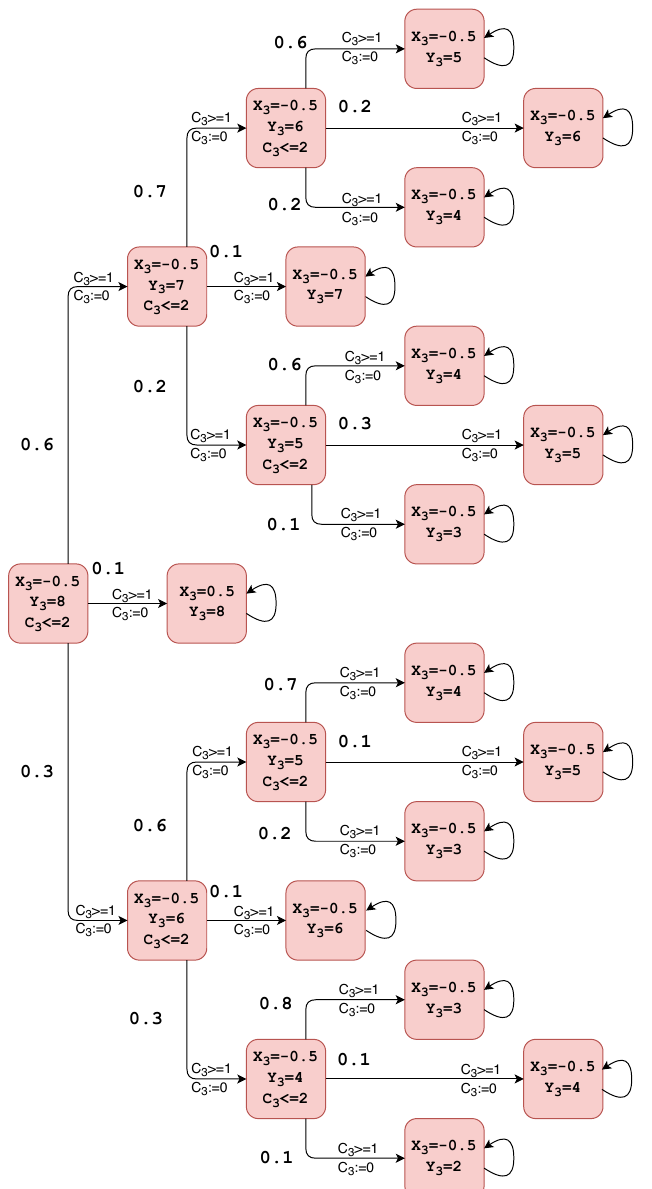
Figure 14. PTP model for the vehicle’s behavior. The verification results for the proposed scenario are shown in Table 3 returned from PRISM for Formula (9), which indicates information about the model generated for both the pedestrian and the car and the chance of collision with every one of them under the current motion plan. Table 3. Verification results for the proposed scenario using PRISM model checker. PTP Model States Transitions Choices Ver. Time Maximum Collision